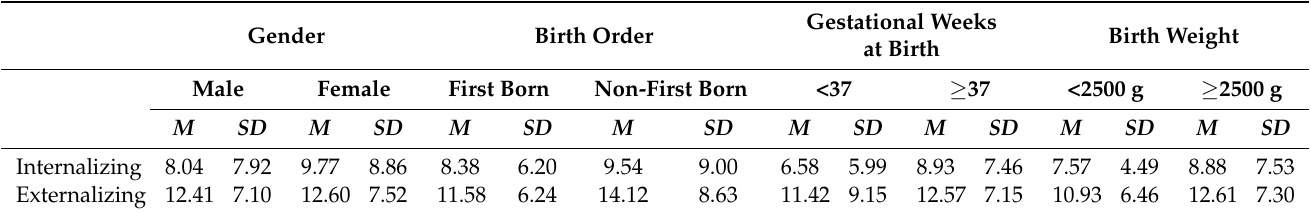
Table 2. Means and standard deviations for toddler’s emotional and behavioral